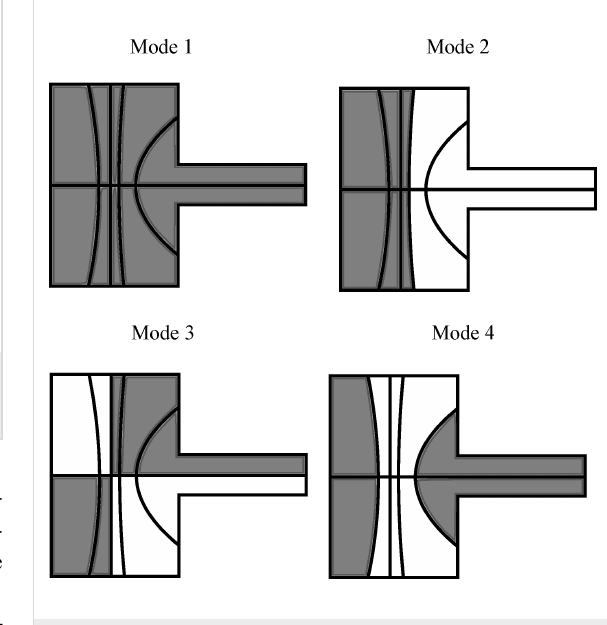
Figure 10: The layout of the piezoelectric layer on the cantilever to optimally actuate and sense M1–M4. The cantilever has 10 separate transducers. The voltage on each transducer is a combination of four voltages to actuate each mode. These four voltages are combined in the positive polarity for the black electrodes and in the negative polarity for white electrodes. The sensor outputs for each transducer are combined in the same fashion for each